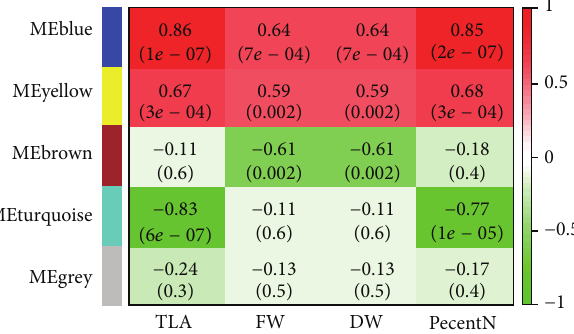
Figure 4: Module-trait association. Each row corresponds to a module and each column corresponds to a specific trait: total leaf area (TLA), fresh weight (FW), frozen weight (DW), and percent nitrogen (PercentN). The color of the cell indicates the correlation coefficient between the module and trait, dark red color indicates high degree of positive correlation, and dark green indicates high degree of negative correlation between each module and trait. The numbers in the cell indicate the module-trait correlation value (top) and 𝑝 value (below).